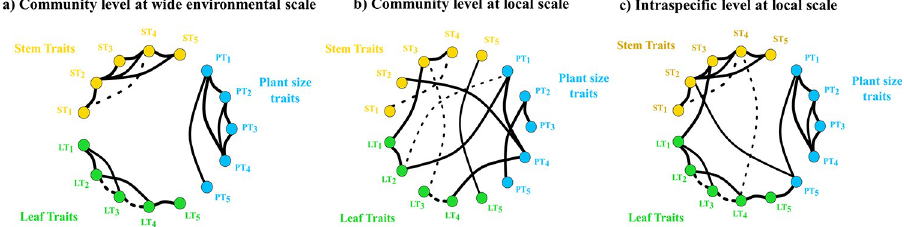
Fig 1. Conceptual figure with general patterns depicted from previous studies of trait correlations (either positive or negative, continuous vs. dashed lines) at different scales (from local to wide environmental spatial scale). Relationships among traits at (a) large scale where trait clusters (PT: plant size traits, ST: stem traits and LT: leaf traits) of numerous species are mostly independent from each other (elaborated from Baraloto et al., 2010; Fortunel et al., 2012; Dı´az et al., 2016). Relationships among traits at (b) the community, local scale with increased level of phenotypic coordination particularly among trait clusters (elaborated from Bucci et al., 2004; Santiago et al., 2004; Ishida et al., 2008; de la Riva et al., 2016; Messier et al., 2017b). Relationships among traits (c) at the intraspecific, local level: we expected an intermediate situation from a) and b) with more relationships within cluster than b) due to genetic constraints, and among clusters than a) due to more integrated